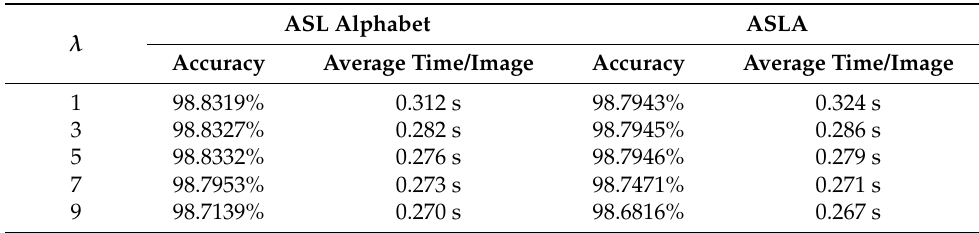
Table 8. Accuracies by 𝛼 in ARS-MA model.